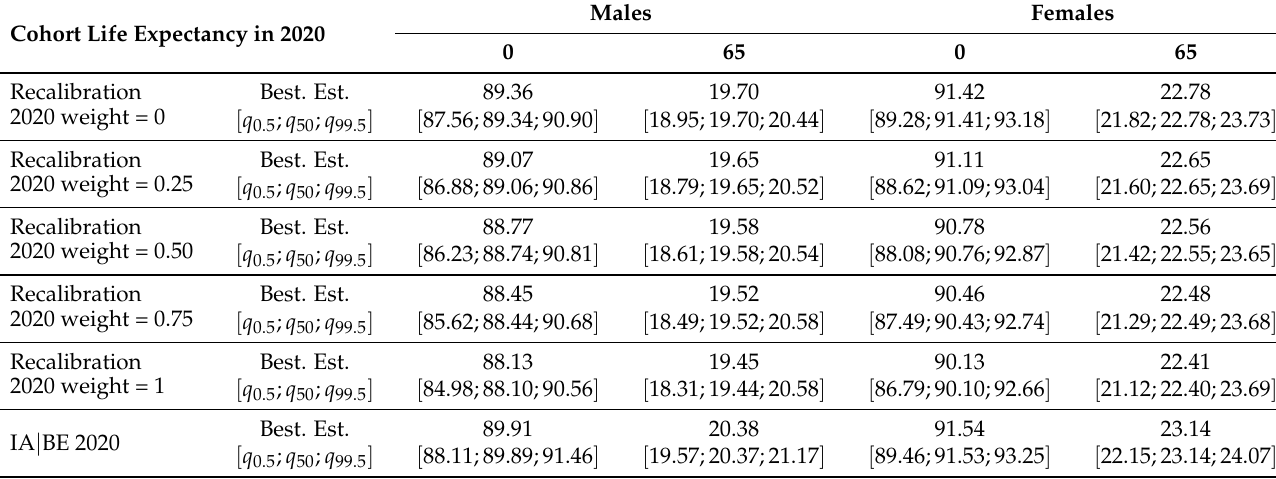
Figure 10. Estimated and projected period life expectancies ˆ e x , t for Belgium. Male ( top ) and female ( bottom ) data, ages 0 ( left ) and 65 ( right ), calibration period 1988–2020, projection period 2021–2070, method of Section 5.1. We show the 0.5%, median (white lines) and 99.5% quantile (fan charts), based on 10,000 simulations, across each weighting scenario. The dark red, dashed line shows the 50% quantile originating from the original IA | BE 2020 model. The blue dots and black line represent the observed and fitted period life expectancies, respectively. Table 2. The cohort life expectancy for a 0 and 65 year old in 2020. The 0.5%, median and 99.5% quantile obtained from 10,000 simulations are shown, for males and females. We obtain the best- estimate of the cohort life expectancy by taking the zero vector for the noise terms in Equation (4) to project the time dependent